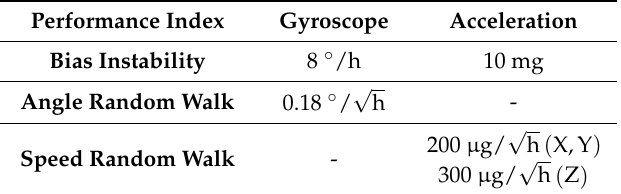
Figure 6. Data acquisition diagram in the kinematic vehicle experiment. Table 3. MEMS gyroscope and accelerometer performance index of the SBG Ellipse-N.